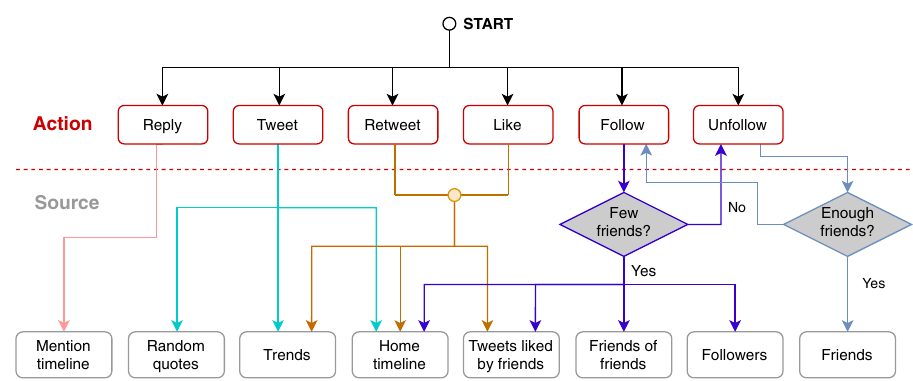
Fig. 6 Drifter bot behavior model. Each action box is connected with boxes that indicate the sources used for that action. For example, the source of a retweet can be a trending tweet, a tweet in the home timeline, or a tweet liked by a friend. Links to actions and sources are associated with the probabilities. Follow and unfollow actions require additional constraints to be satis fi ed (gray